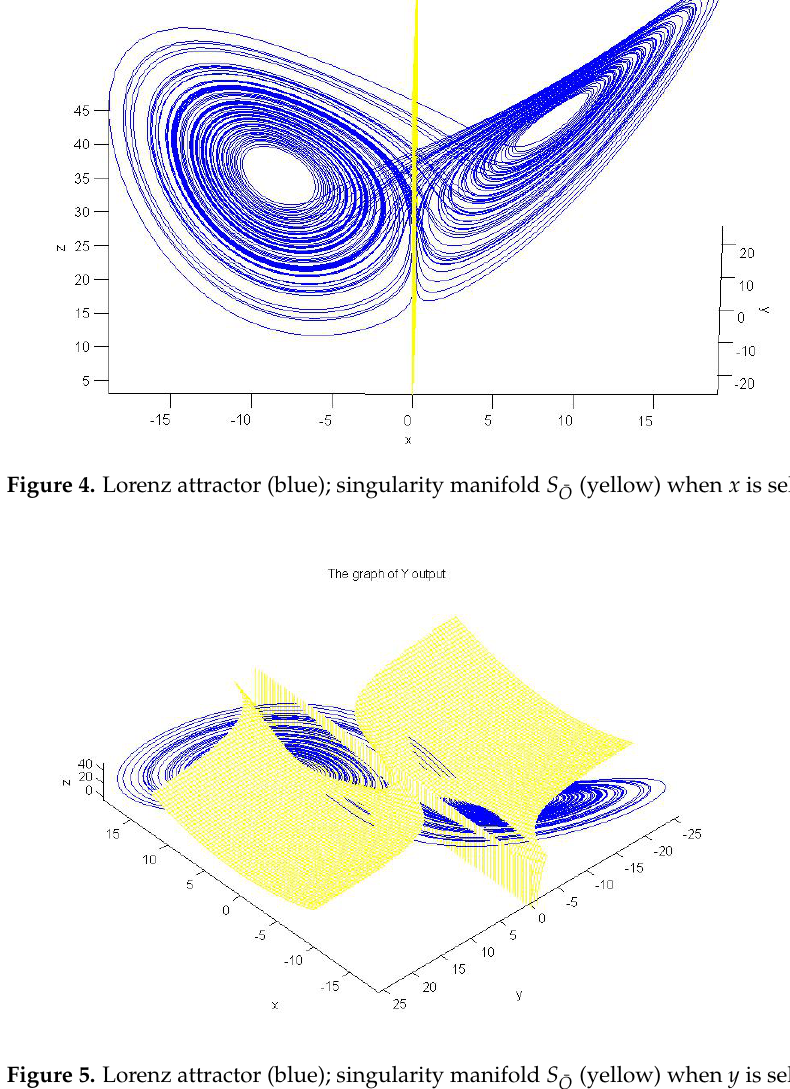
Figure 5. Lorenz attractor (blue); singularity manifold S ¯